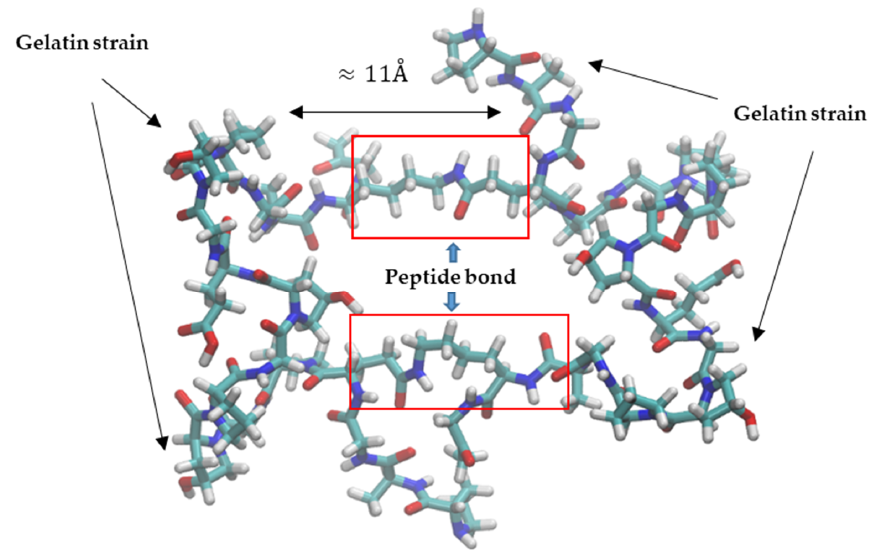
Figure 3. Molecular model of gelatin-based hydrogel cross-linked with microbial transglutaminase (mTGase). The peptide bond is formed between Gln and Lys residues of two gelatin strands, thus limiting the accessible volume between them and enhancing the mechanical resistivity of the obtained polymeric